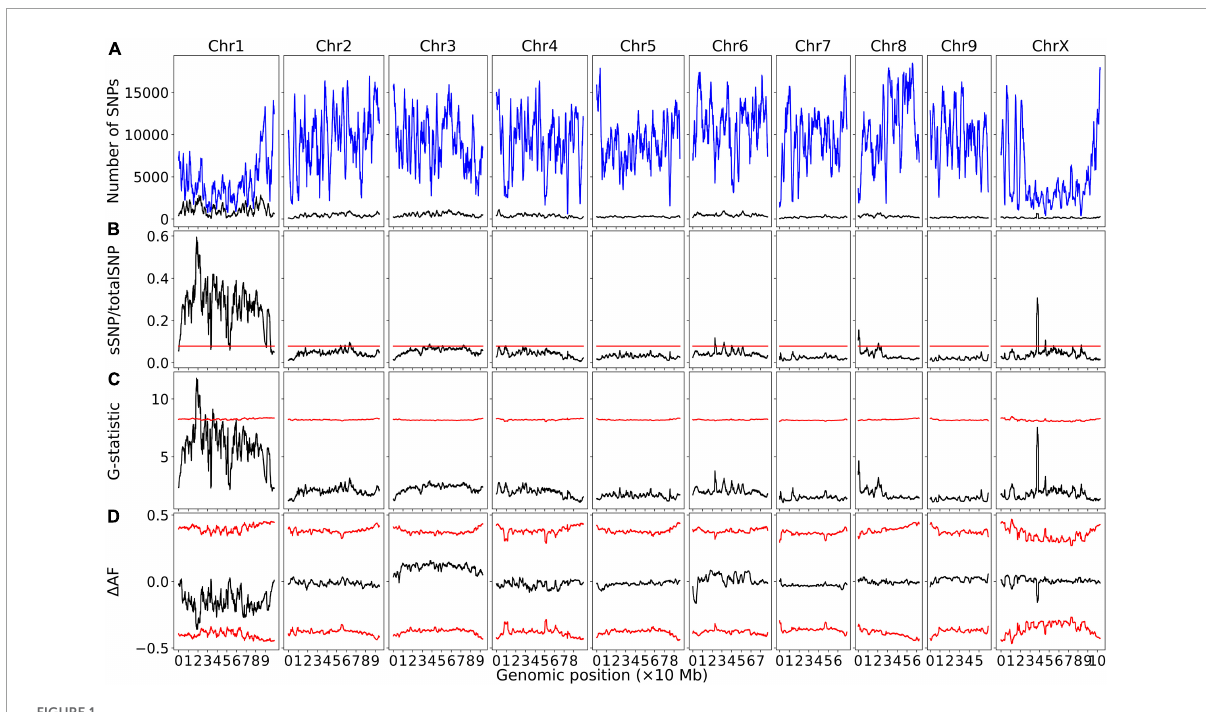
FIGURE1 Bulk segregant analysis examining pools of photoperiod-insensitive and photoperiod-sensitive plants from GVA-H-20-1080. A physical genomic window size of 2 Mb and step size of 10 kb is shown. (A) Chromosomal distribution of SNPs. Total SNP number is in blue and significant SNP number (Fisher Exact Test P < 0.01) is in black. (B) Ratio of significant SNPs:Total SNPs across chromosomes. (C) G-Test statistic values across chromosomes. (D) Delta-allele frequency ( (cid:49) AF) values across chromosomes. Red lines represents significance thresholds determined by simulation of 10000 SNPs given allele depths at the 99.5th percentile for significant SNPs:Total SNPs and G-statistic, and the 99% confidence interval for (cid:49) AF